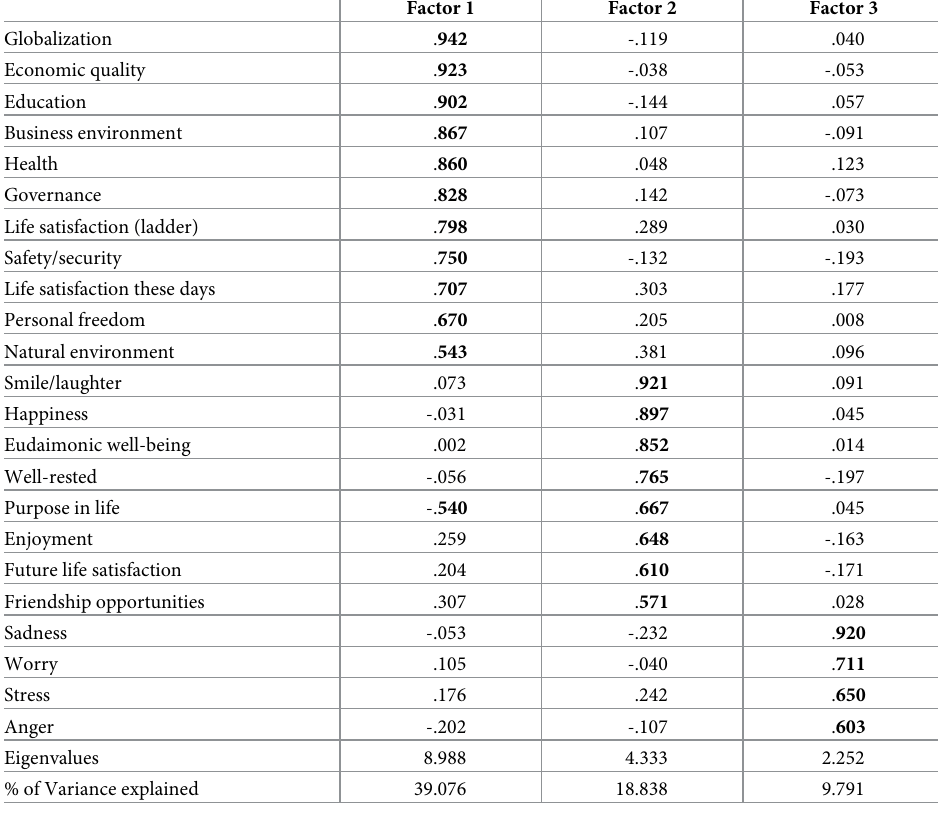
Table 4. Results of exploratory factor analysis (2007–2012, N = 88).